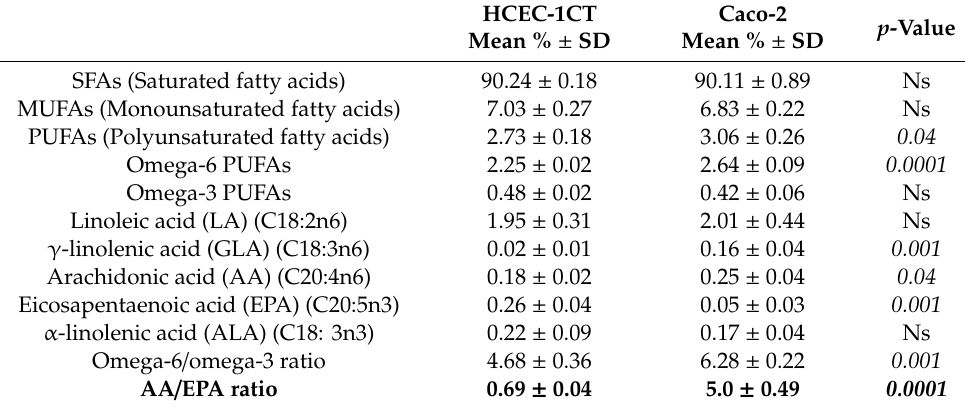
Table 1. Mean percentage of the fatty acid composition of exosome membranes extracted from HCEC-1CT and Caco-2 cell lines. All data represent the results of three di ff erent experiments (mean % ± SD). p -value has been determined by a paired Student t test. The bold font is represent the ration between arachidonic acid and eicosapentanoic acid for both cell lines, with standard